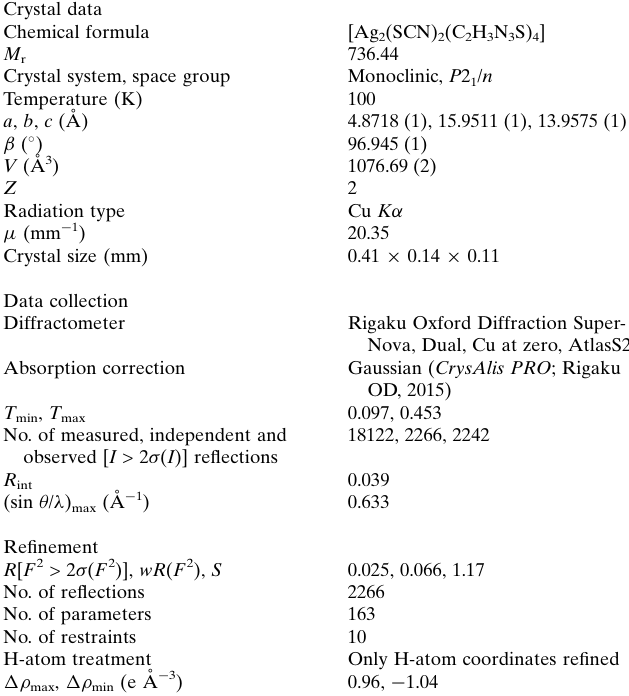
Crystal data Chemical